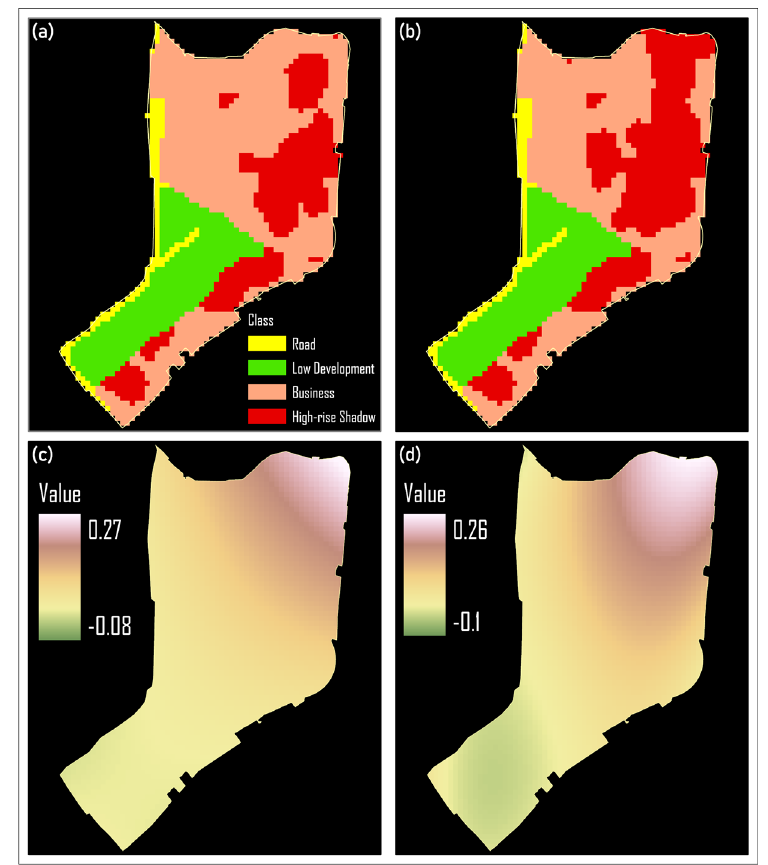
Figure 12. Classifications, created by manual and semi-automated methods, of the Brickell Figure12. Classifications, createdbymanualandsemi-automatedmethods, oftheBrickellneighborhood neighborhood derived from Landsat 5 TM data used as LCM inputs; ( a ) 11/20/03, ( b ) 11/17/08. derived from Landsat 5 TM data used as LCM inputs; ( a ) 20 November 2003, ( b ) 17 November 2008. Polynomial transition trends created in LCM; ( c ) 2nd order, ( d ) 3rd order. Polynomial transition trends created in LCM; ( c ) 2nd order, ( d ) 3rd